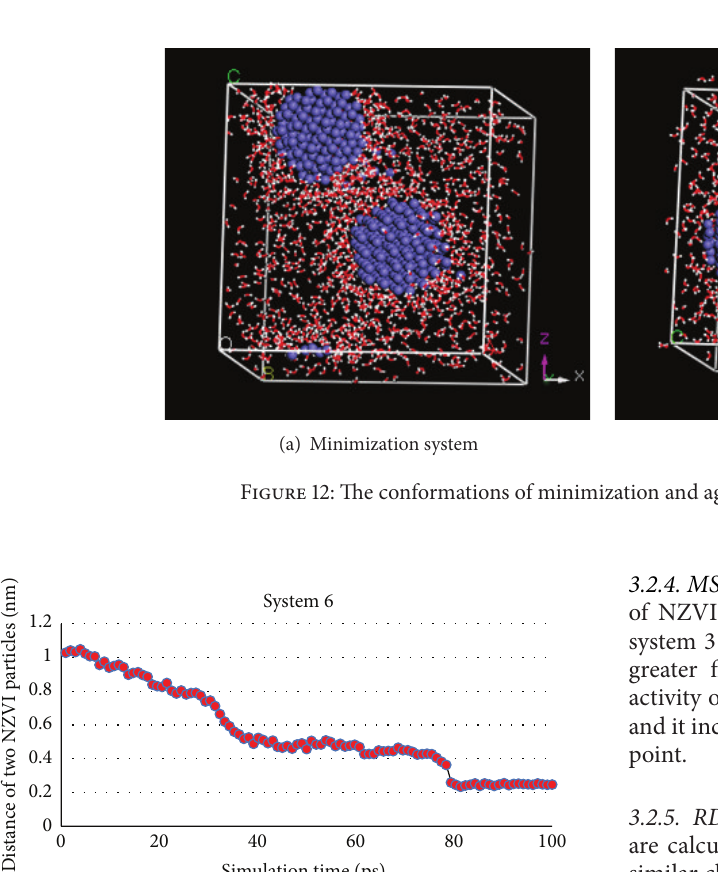
Figure 11: Conformations of initial and minimization system of system 6.